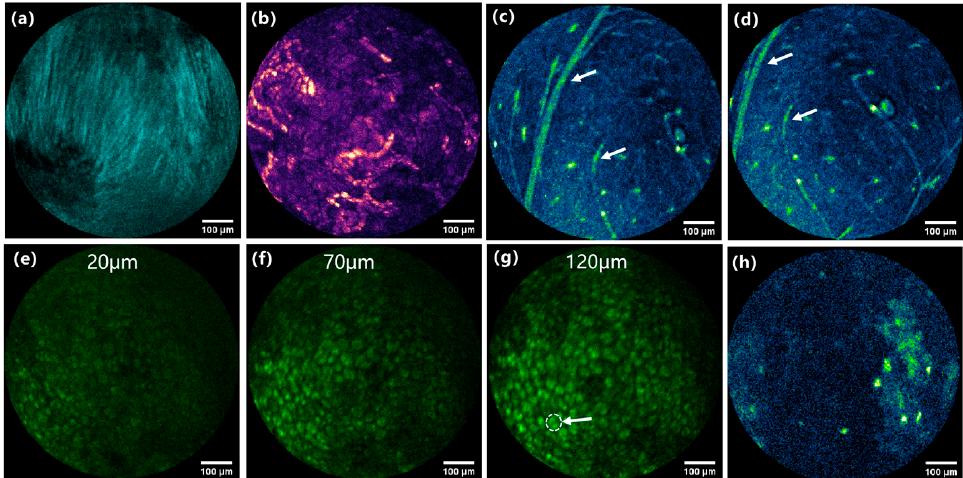
Figure 8. TPEM imaging results: ( a ) heart; ( b ) kidney; ( c , d ) brain tissue; ( e – g ) stomach inner wall tissue at 20 µm, 70 µm, and 120 µm depths; and ( h ) in vivo brain tissue. Scale bars: 100 µm.